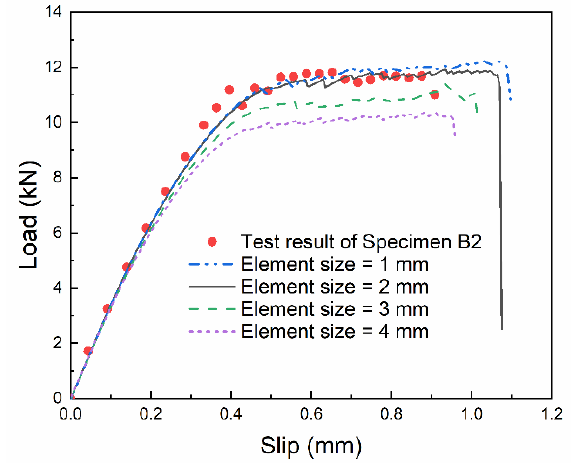
Figure 11. Mesh convergence analysis.